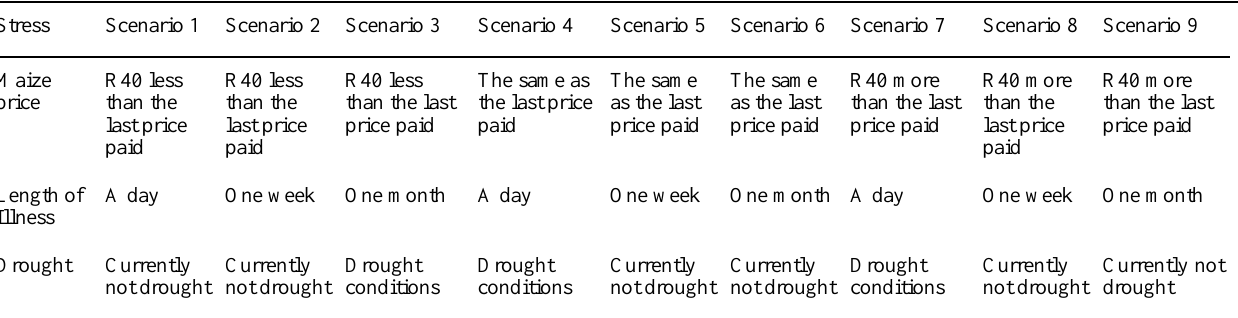
Table 1. Nine scenarios, based on stress and range of possibilities for each stress identified by respondents, presented in the stated preference questionnaire. R = South African